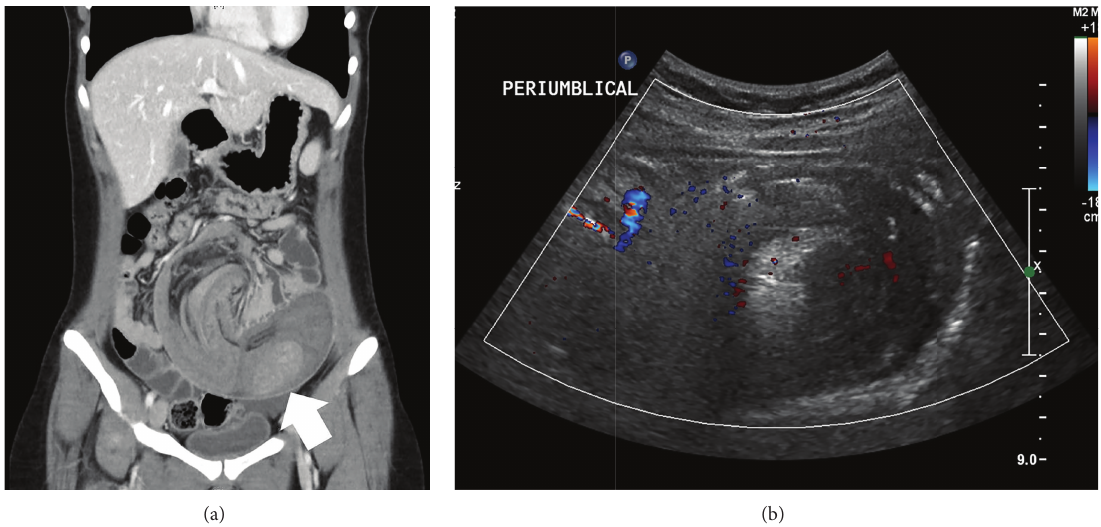
Figure 1: Abdominal pelvic computed tomography and ultrasonography. (a) Coronal view of the CT scan shows a long segment of jejunojejunal intussusception and polyps within the jejunum (white arrow). (b) Sonographic finding of a target sign suspected to be intussusception.